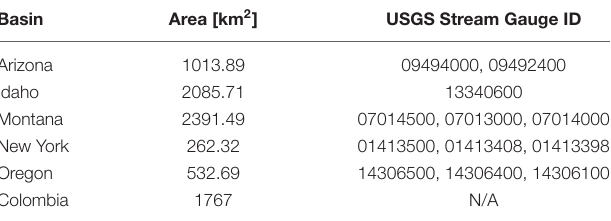
TABLE 1 | Watershed attributes.